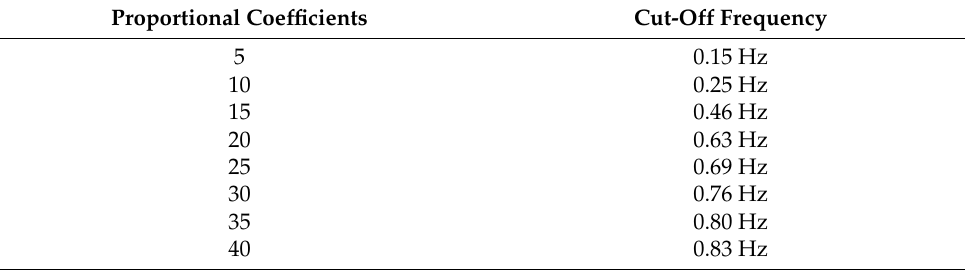
Table 3. The cut-off frequency in different proportional coefficients.